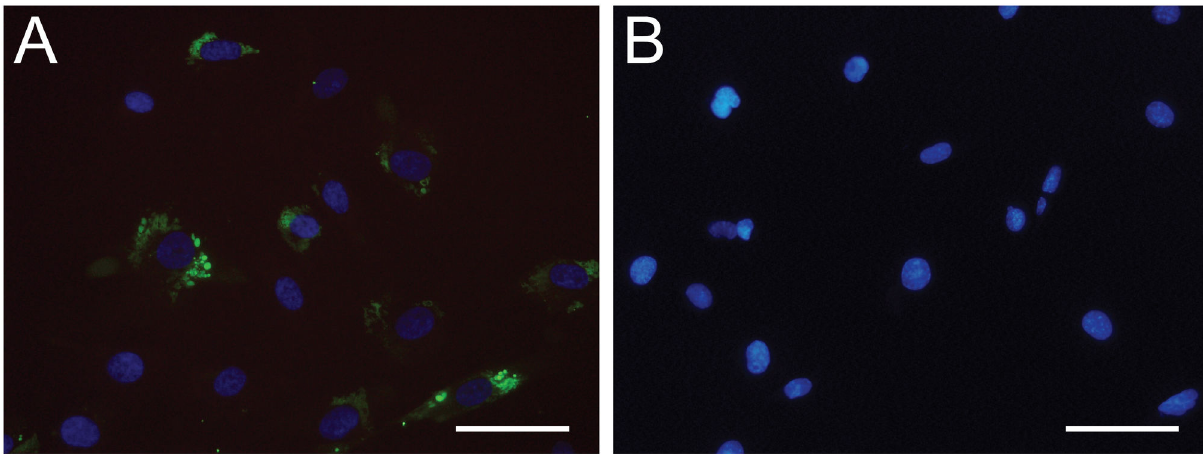
Figure 9. Cell staining with soluble M3-H12 Predator antibody. The cell lines HVBP (A) and HMEC-1 (B) were stained with selected M3-H12 antibody and detected with Protein A conjugated with Alexa Fluor 488 (green). The cell nuclei were stained with DAPI (blue) (scale bar, 20